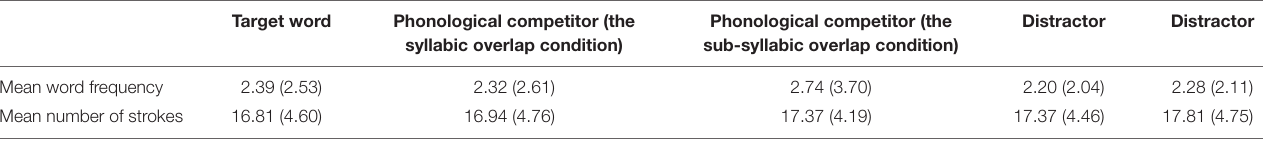
TABLE 1 | Lexical properties of the experimental materials in Experiment 1 and 2. Target word Phonological competitor (the Phonological competitor (the syllabic overlap condition) sub-syllabic overlap